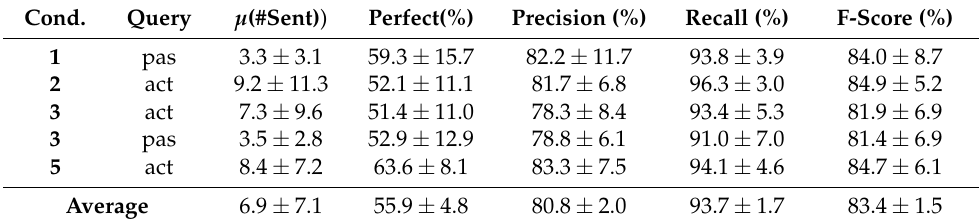
Table 6. Precision, Recall and F-Score values ± their standard deviation obtained on the test conditions. Cond. Query µ (#Sent) ) Perfect(%) Precision (%) Recall